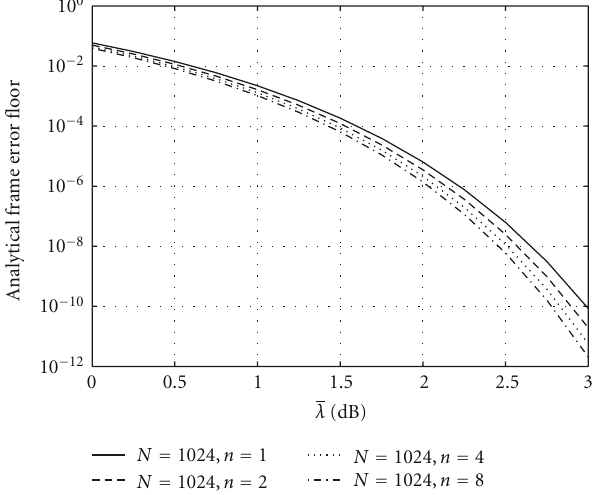
Figure 4: Analytical Frame Error Rate at the error floor level for the clipping threshold λ . In the case, N = 1024 and the QPSK modulation is